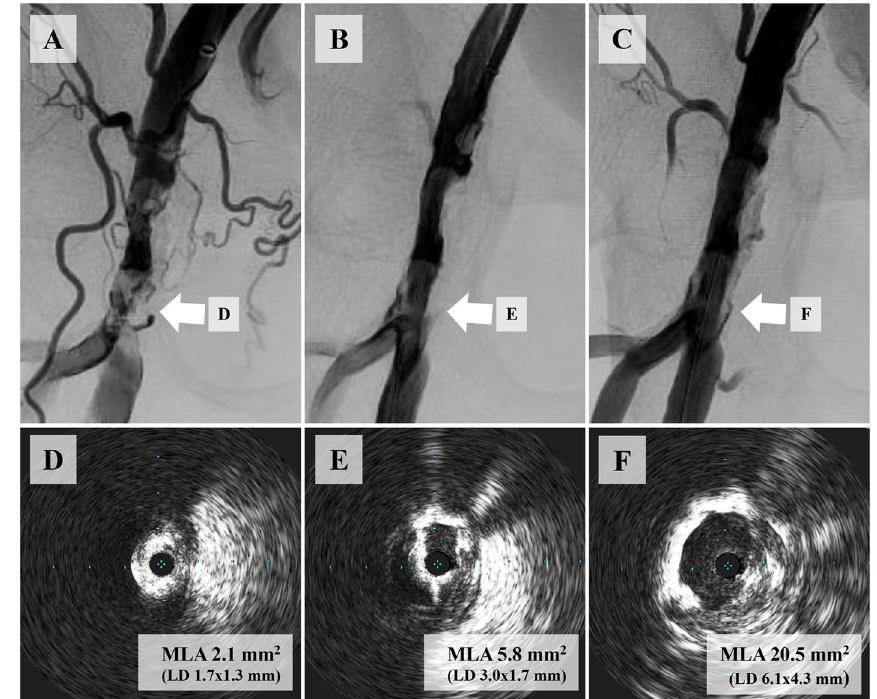
Fig. 1 Representative case of lesion morphology and IVUS-evaluated MLA before and after fracking and balloon angioplasty. A Initial angiography shows a severely calcified plaque in the right CFA. B Initial IVUS evaluation demonstrates a preprocedural MLA of 2.1 mm 2 (LD, 1.7 Subsequent angiography and IVUS show residual stenosis of 33% and a periprocedural MLA of 5.8 mm 2 (LD, 3.0 using a 7.0 mm noncompliant balloon. E After fracking, the final angiography shows a satisfactory image with a stenosis rate of 17%. F Post-fracking IVUS evaluation demonstrates a postprocedural MLA of 20.5 mm 2 (LD, 6.1 diameter; MLA, minimum lumen